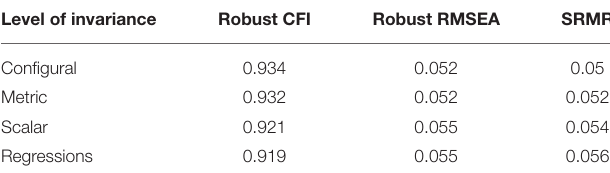
TABLE 2 | Invariance of analytic thinking in prediction of COVID-19 preventive behaviors and policy support across the three political contexts ( N = 12,490). Level of invariance